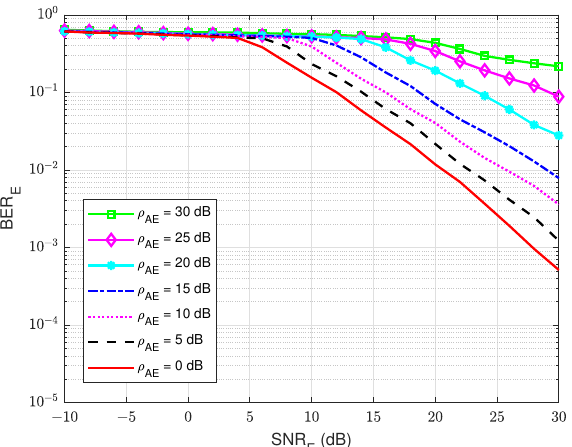
Figure 11. BER E versus the SNR E in case of a passive